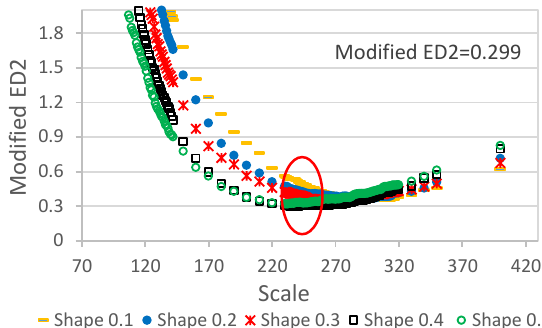
Figure 6 . Modified ED2 computed by using AssesSeg for MRS outputs from Deimos-2 PANSH ATCOR orthoimage.